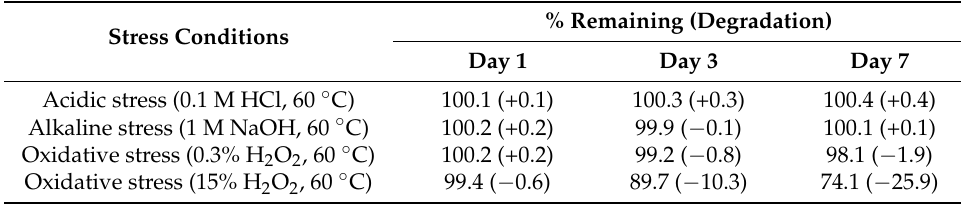
Table 3. Forced degradation studies of 1% eye drop oily formulation.